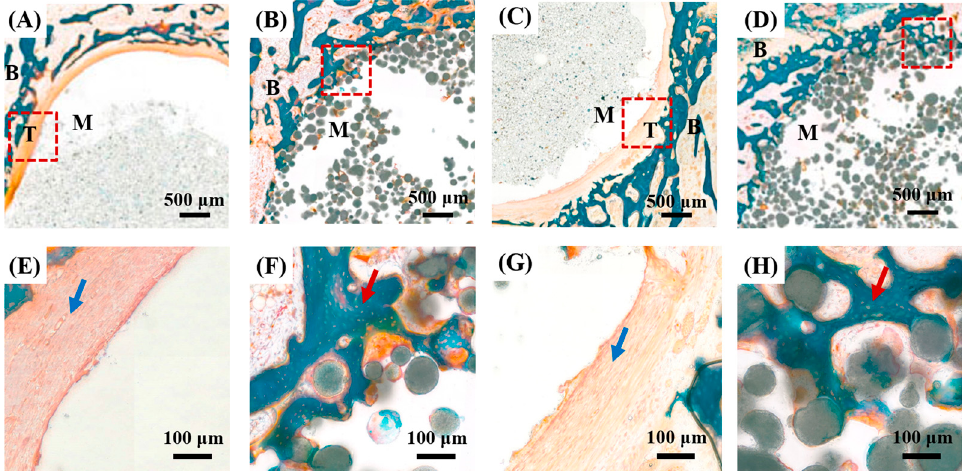
Figure 11. Representative histological cross-sectional images of PMMA containing barium sulfate ( A , E , C , G ) and PMMA/HA composite with an HA content of 40 vol % ( B , F , D , H ) after 4 weeks ( A , E , B , F ) and 8 weeks ( C , G , D , H ) of implantation (B: bone, T: soft tissue, M: material). Blue and red arrows indicate soft tissue and new bone, respectively.